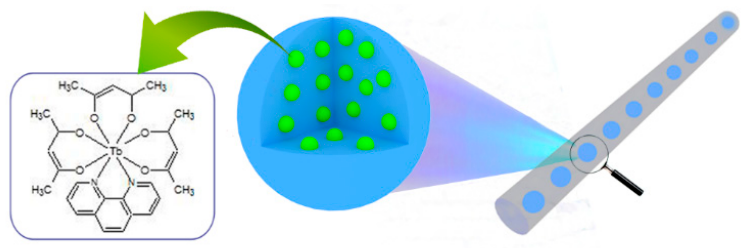
Figure 1. Schematic illustration of electrospun fiber containing luminescent SiO 2 –Tb 3+ nanoparticles.